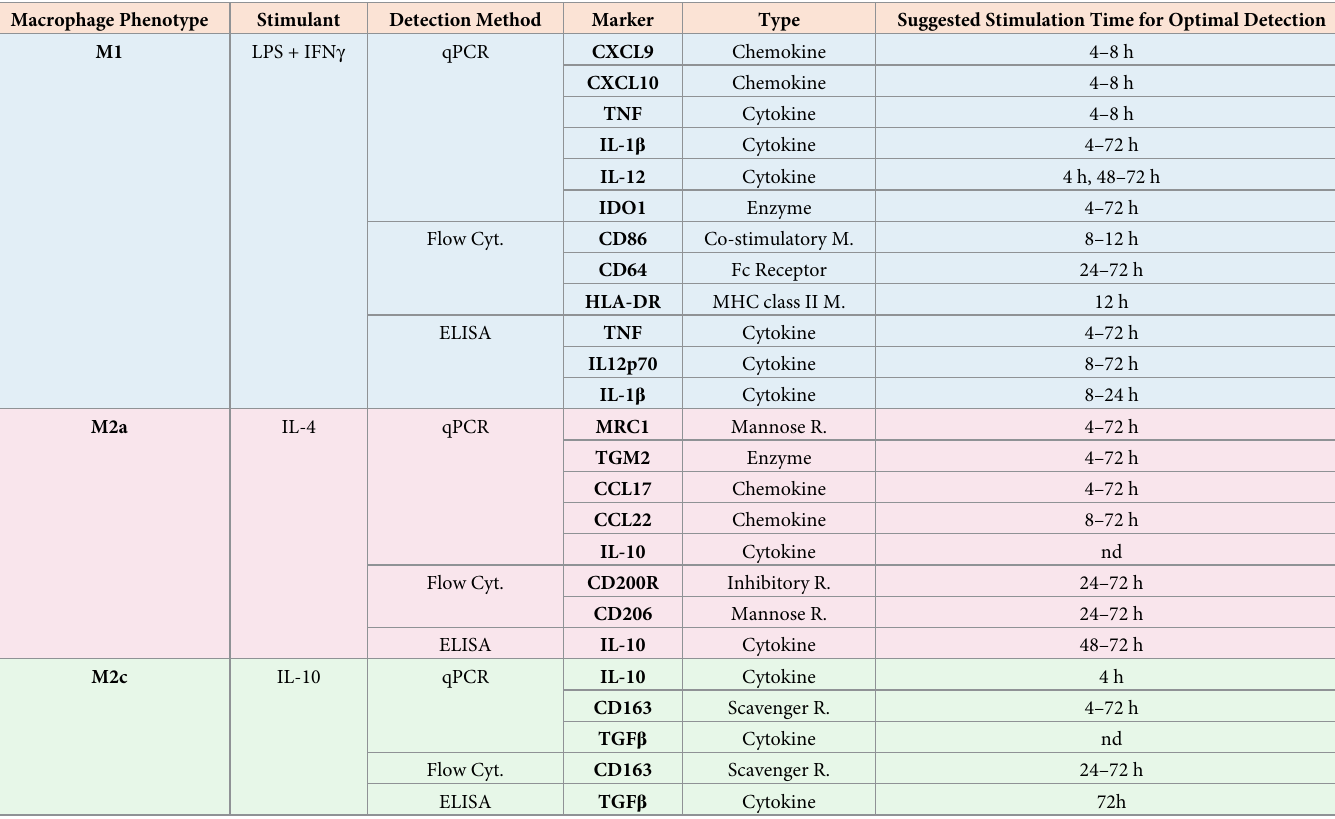
Table 1. Suggested stimulation times for the detection of M1, M2a, and M2c polarization markers in human monocyte-derived macrophages. Macrophage